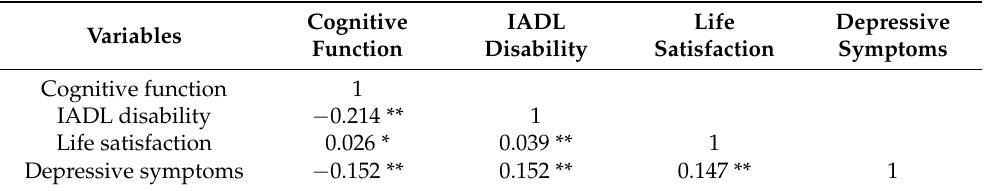
Table 2. Correlations among cognitive function, IADL disability, life satisfaction, and depressive symptoms.